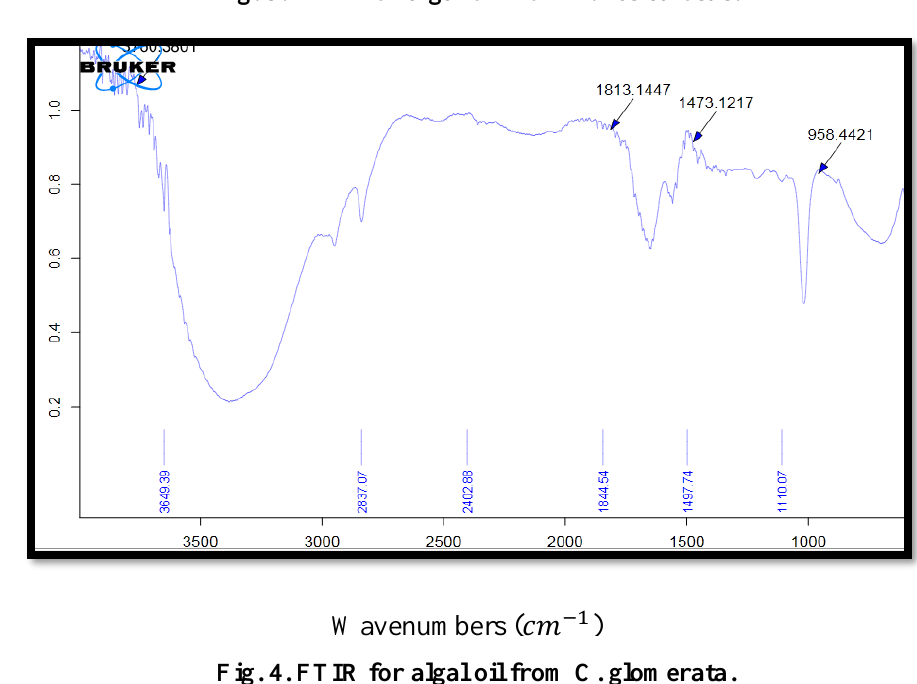
Fig. 3. FTIR for algal oil from F. vesiculosus.